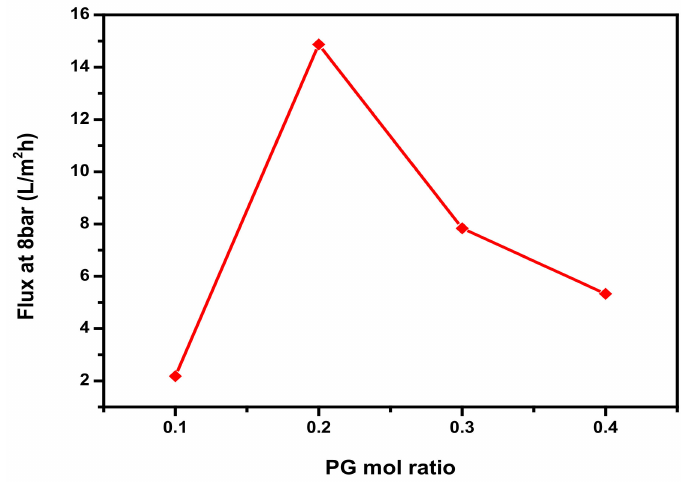
Figure 6. Water fluxes of CA/propylene glycol in the ratio range of 0.1 to 0.4 at 8